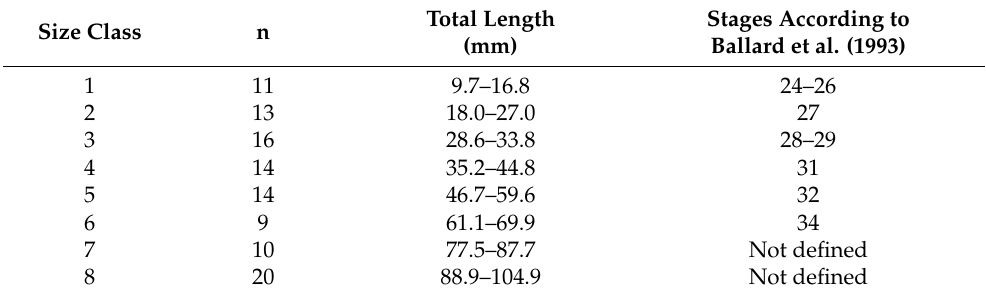
Table 2. Overview of examined developmental stages and size classes of Scyliorhinus canicula